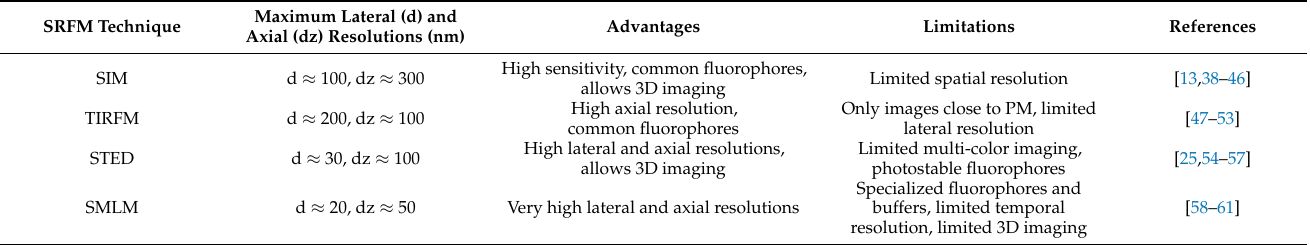
Table 1. Main characteristics, advantages, and limitations of SRFM techniques applied to the study of MCS.